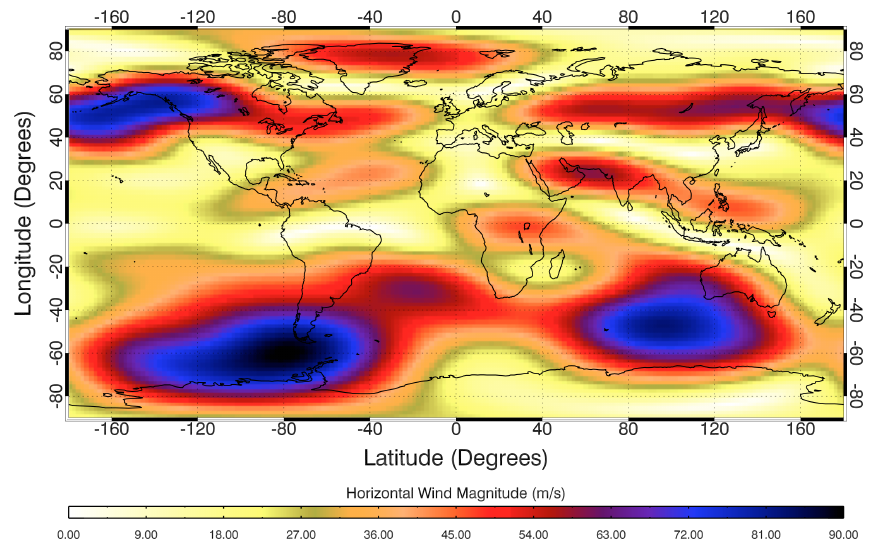
Fig. 7. A global plot of the magnitude of horizontal wind speed present on 1 January at 00:00UT at 100km in Fig. 2a and b. The color bar shows wind speed in ms − 1 . The wind pattern shown here is present throughout the day and is fixed in local time. Notice the large variations in the magnitude of horizontal wind speed and its geographic distribution, which effects trail evolution.